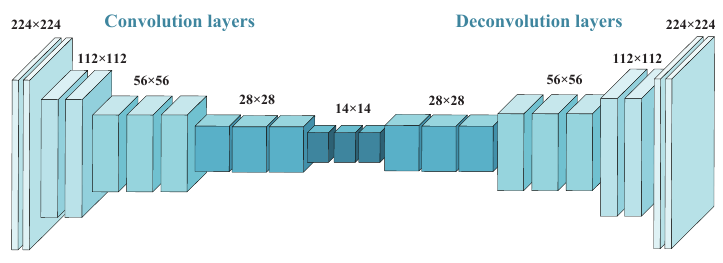
Figure 3. Illustration of network for static saliency detection.